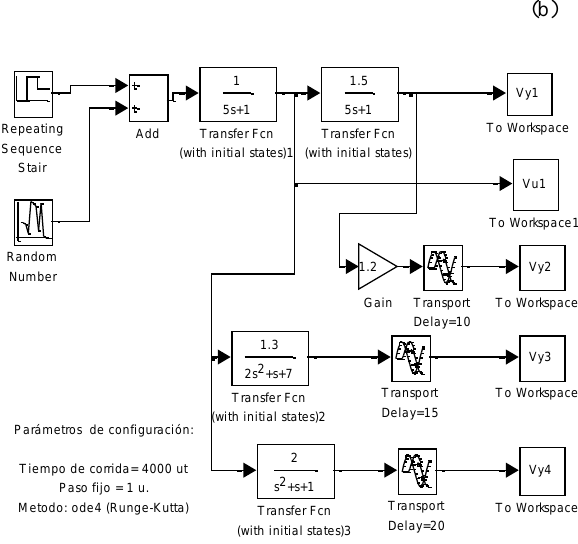
Figura 5. Modelo Simulink para generar señales sintéticas.